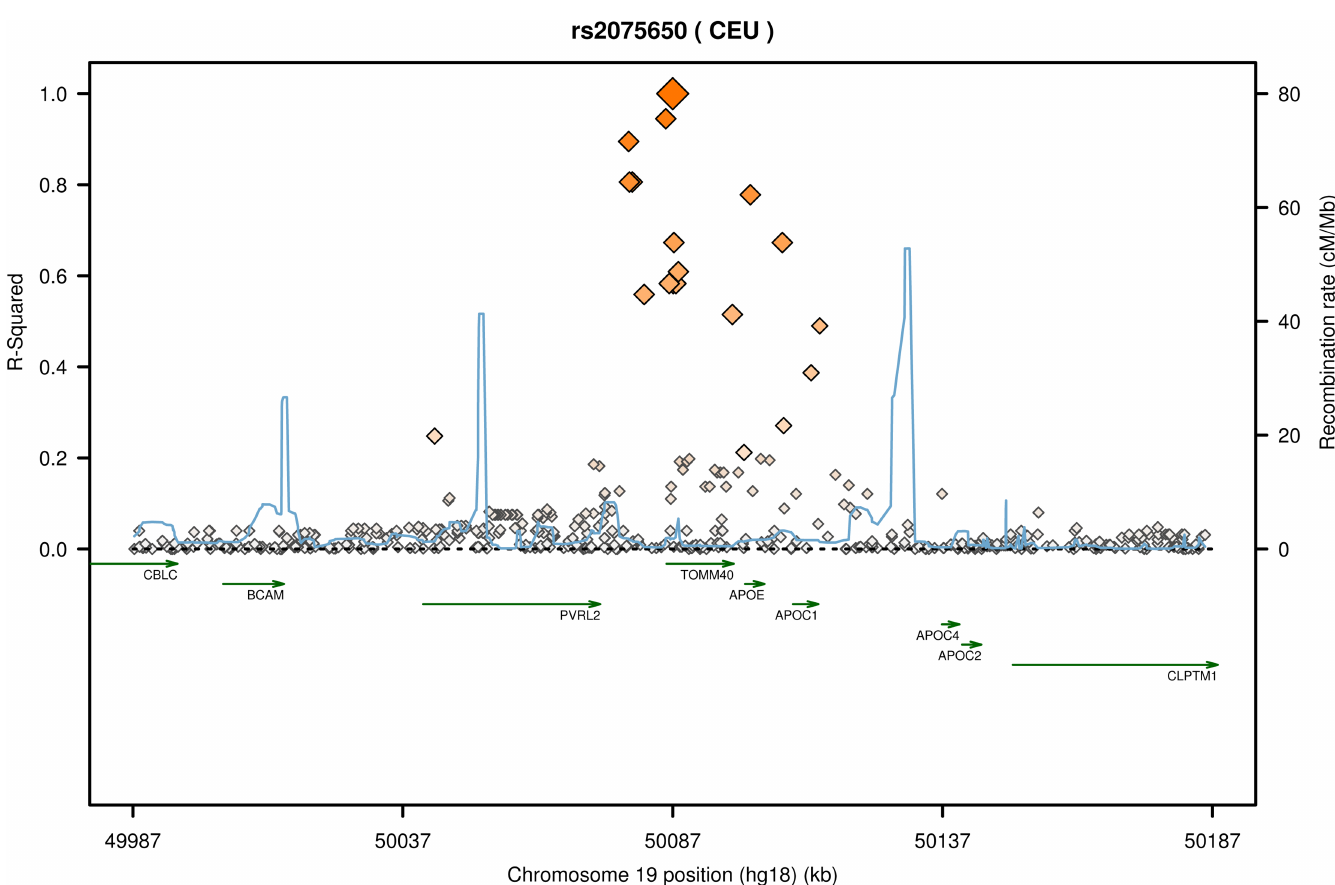
Fig 1. Recombination rate and linkage disequilibrium at the rs2075650 locus in the CEU population. Generatedusing SNAP (http://archive. broadinstitute.org/mpg/snap/ldplot.php)[18].